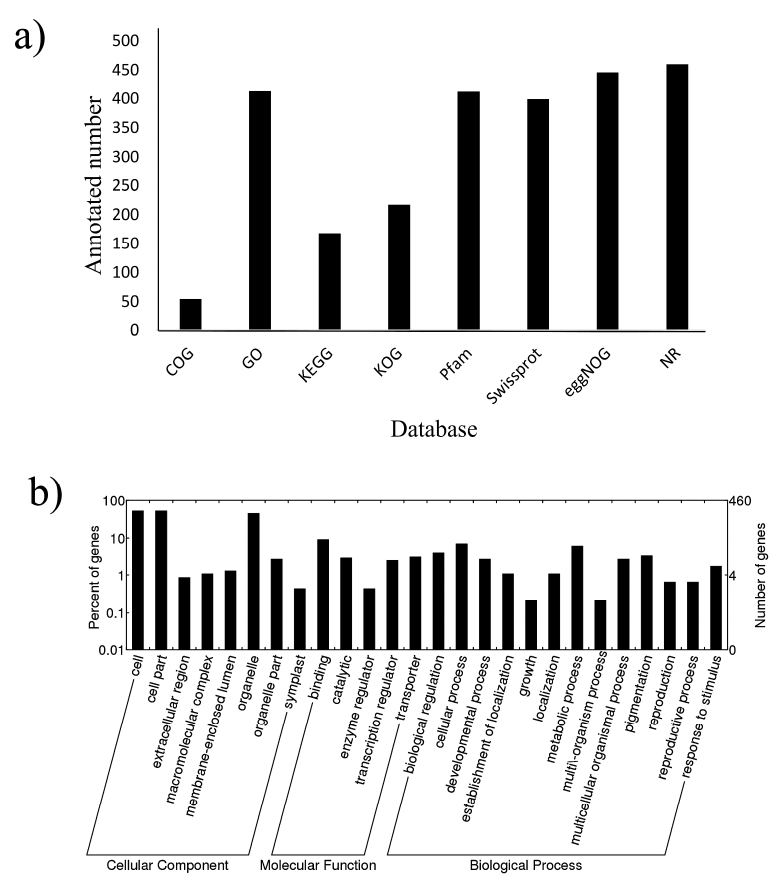
Figure 4. Diagrams of differentially expressed known ( a ) and novel ( b ) miRNAs between each treatment comparison.